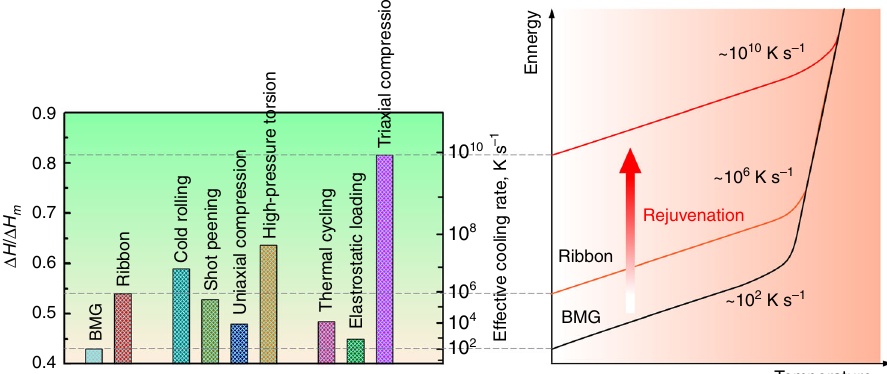
Fig. 6 Relative enthalpies of metallic glasses (normalized by the heat of melting Δ H m and relative to the annealed crystal 1 ) in different as-cast conditions, and subjected to plastic deformation, or to other processes such as elastostatic loading 2 and thermal cycling 30 . Higher relative enthalpy corresponds to glassy states expected to be achieved at higher cooling